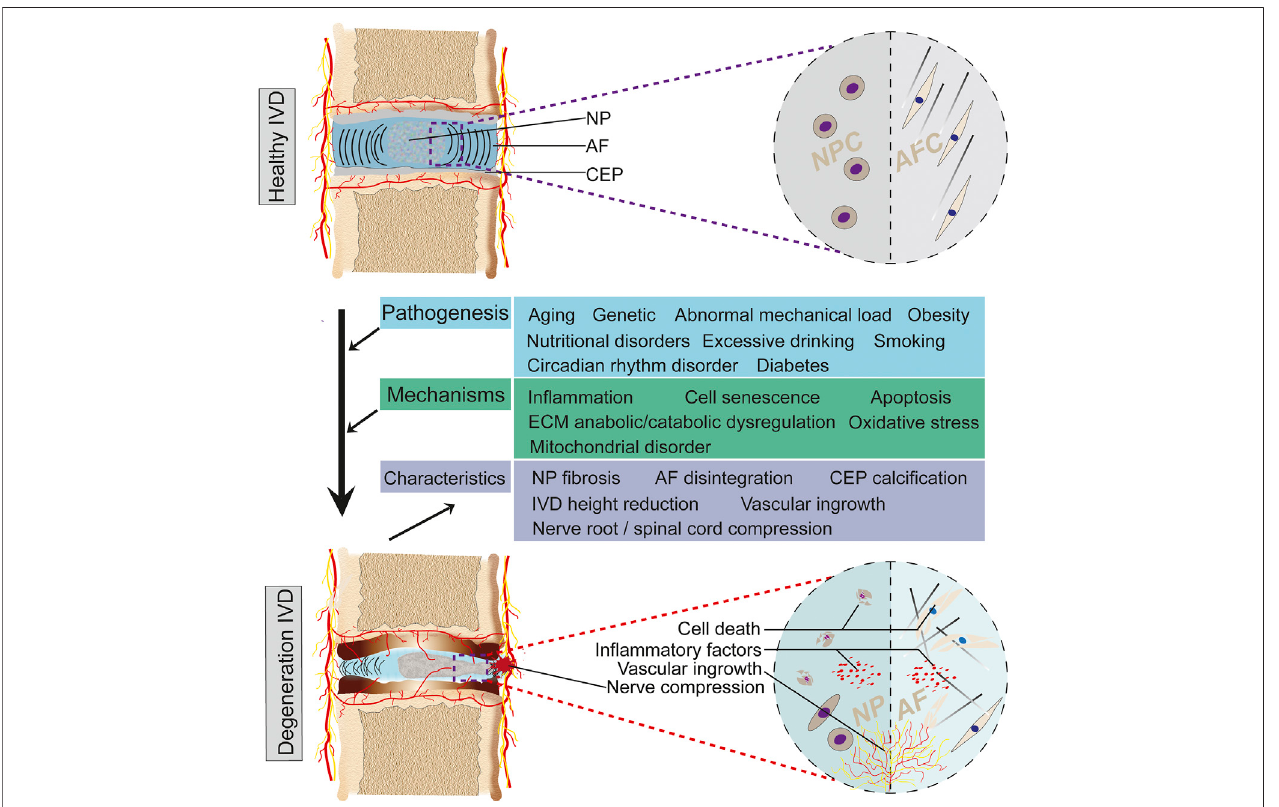
FIGURE 2 | Degenerative process of IVD. IVD gradually degenerates in response to multiple pathogenic factors. Pathogenic factors include aging, genetics, nonphysiologicalmechanicalloading,nutritionaldisorders,etc.ThesefactorsultimatelyleadtoIVDDthroughpathologicalmechanismssuchasin fl ammation,apoptosis, ECM anabolic/catabolic dysregulation and oxidative stress. The degenerative process exhibits a series of features such as highly decreased IVD, NP fi brosis, AF disintegration, and vascular ingrowth.